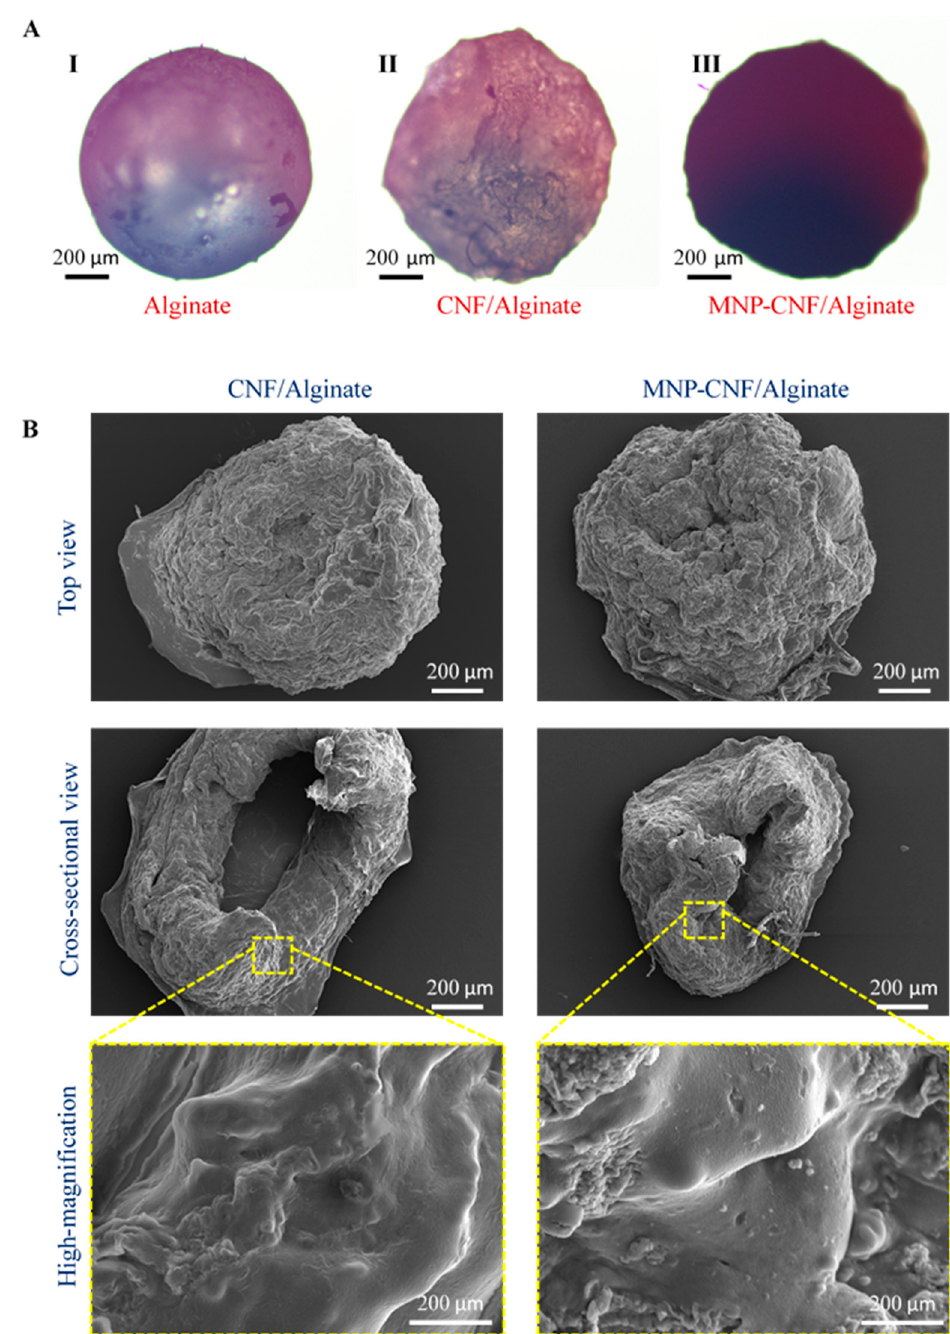
Figure 2. Morphology of dry composite beads: ( A ) Bright-field optical microscopy revealing the opacity and texture of dry beads made of: I . alginate only, II . nanocellulose incorporated alginate (CNF/alginate) and III . magnetic nanocellulose incorporated alginate (MNP–CNF/alginate). ( B ) SEM images of dry beads.